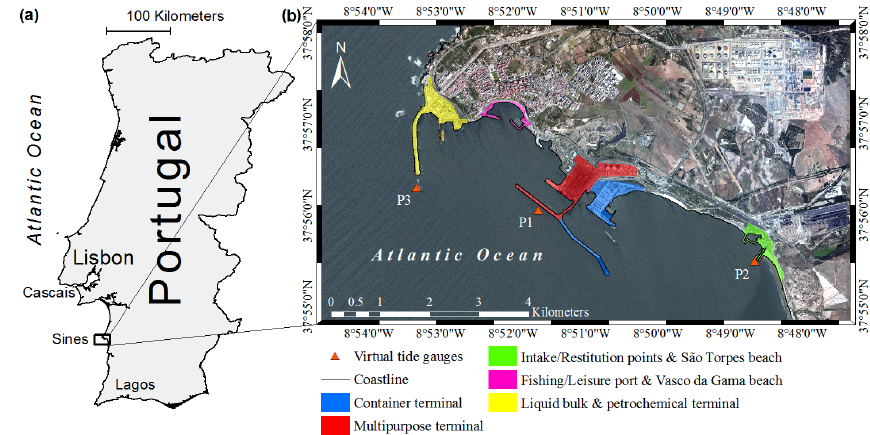
Figure 2. Panel (a) : general map, showing location of Sines test site; panel (b) : test site map identifying general features and tide gauges for synthetic wave